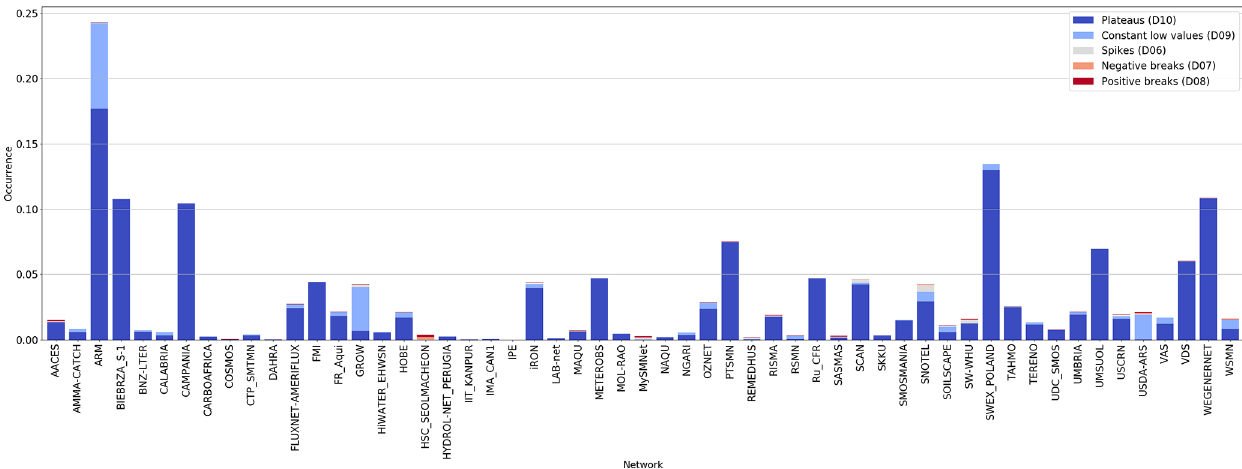
Figure 6. Fractions of spectrum-based quality flags per network. Notice that, in principle, the cumulative sum of fractions can be > 1 as the occurrence of each flag ranges between 0 and 1. Table 4. Global validation results of surface soil moisture of ERA and ESA CCI soil moisture against ISMN (masked and unmasked for quality flags) for the period 2001–2019. The results for ESA CCI were produced with the QA4SM validation service (https://qa4sm.eu/, last access: 28 October 2021). The results are accessible at https://doi.org/10.5281/zenodo.4288919 (Aberer, 2020a) (absolute values – no flags), https://doi.org/10.5281/zenodo.4288921 (Aberer, 2020b) (absolute values – with flags), https://doi.org/10.5281/zenodo.4288915 (Aberer, 2020c) (anomalies – no flags), and https://doi.org/10.5281/zenodo.4288913 (Aberer, 2020d) (anomalies – with flags). Note: ubRMSD is